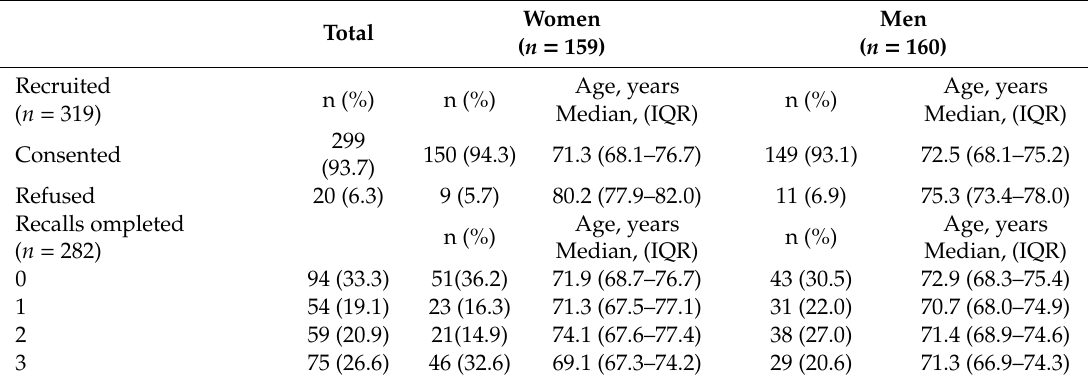
Summary of study recruitment for the myfood24 feasibility study within the CHARIOT-Pro